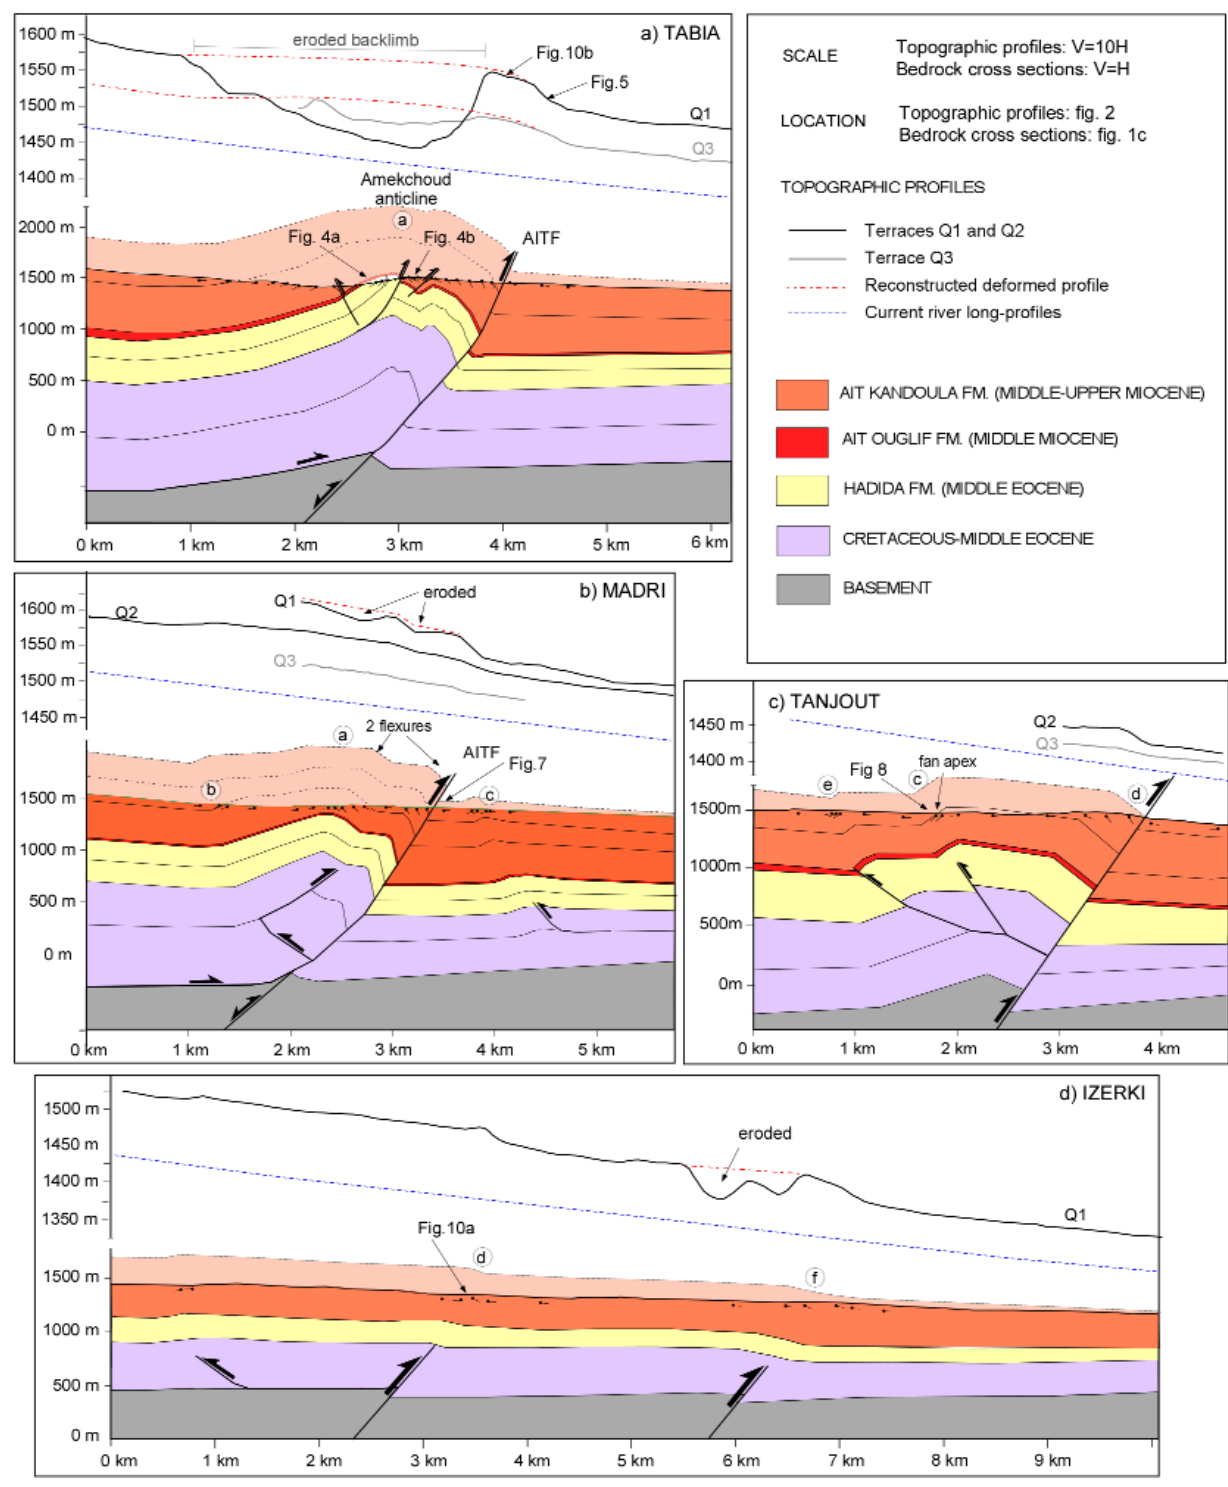
Figure 3. Topographic profiles of Quaternary terraces and geologic cross-sections of the northern Ouarzazate Basin. The topographic profiles were constructed from DEM SRTM90, and the geological cross-sections were based on field data and seismic reflection profiles. The location of topographic profiles is as indicated in Figure 2. The locations of the geological profiles are slightly offset from the Quaternary topographic profiles for the sake of bedrock exposure, and are shown in Figure 1c. Circled letters indicate the tectonic structures labeled in Figure 2 and described in the